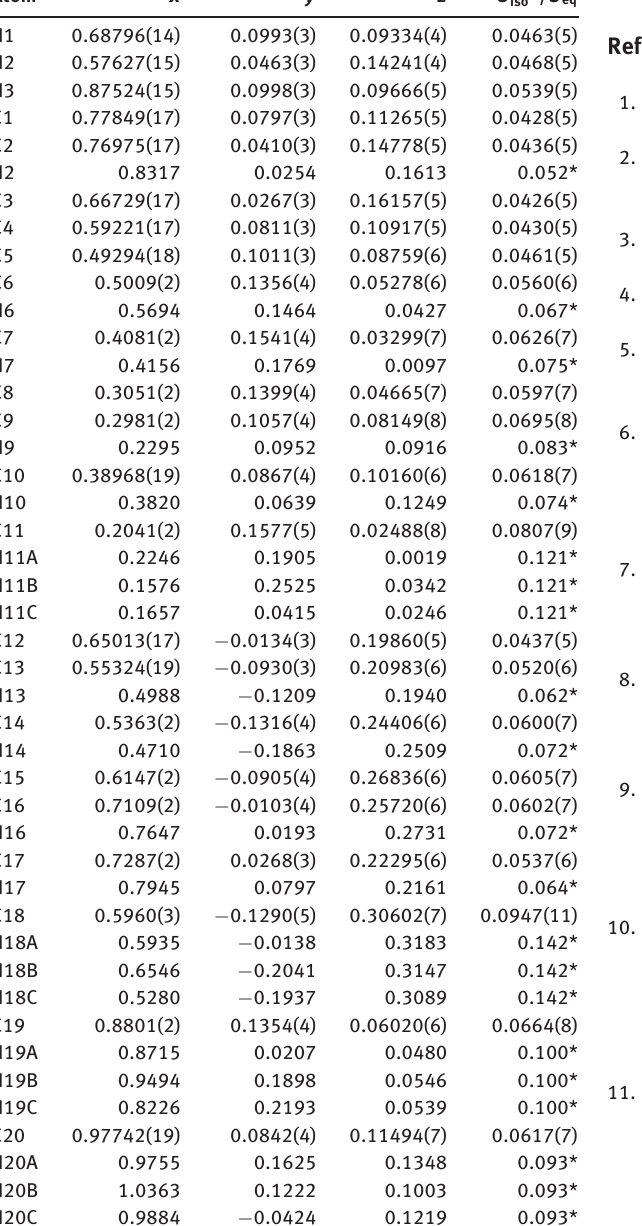
Table 2: Fractional atomic coordinates and isotropic or equivalent isotropic displacement parameters (Å 2